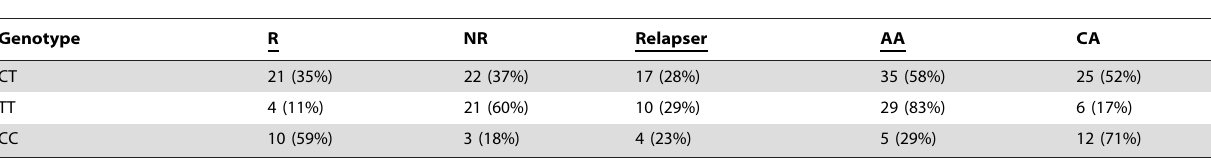
Table 3. IL28 Genotype analysis (112/130 patients).